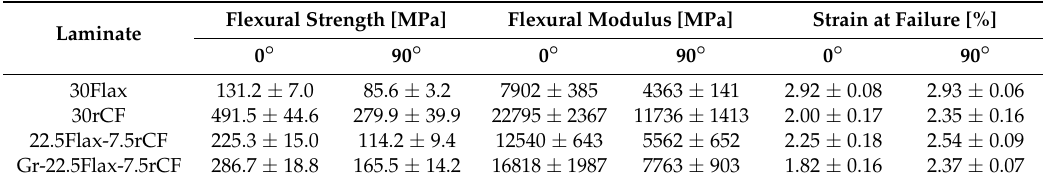
Table 3. Data for flexural strength ( σ ), flexural modulus (E) and strain at break ( ε ) testing in 0 ◦ and 90 ◦ laminate directions with standard deviations. All layers of the laminates are pointing in the same direction. 0 ◦ corresponds to the machine direction (MD) in nonwoven. 90 ◦ corresponds to the cross direction (CD) in